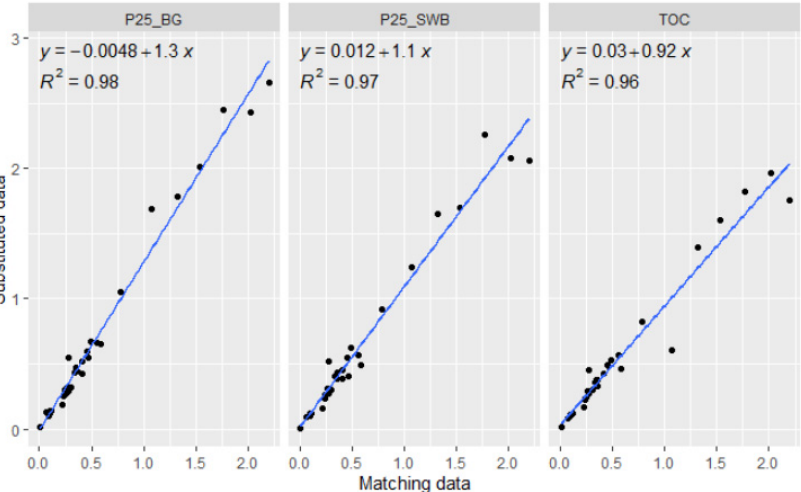
Figure 9. The comparison of the PNEC Pro calculated RCR for Zn between the matching data and substituted data (P25_BG—the 25th percentile of the available DOC data and/or the DOC data calculated by the TOC from the Bulgarian monitoring network results during 2020; P25_SWB—the 25th percentile of the DOC data calculated by the TOC for the respective water body; TOC—the matching DOC data calculated by TOC).